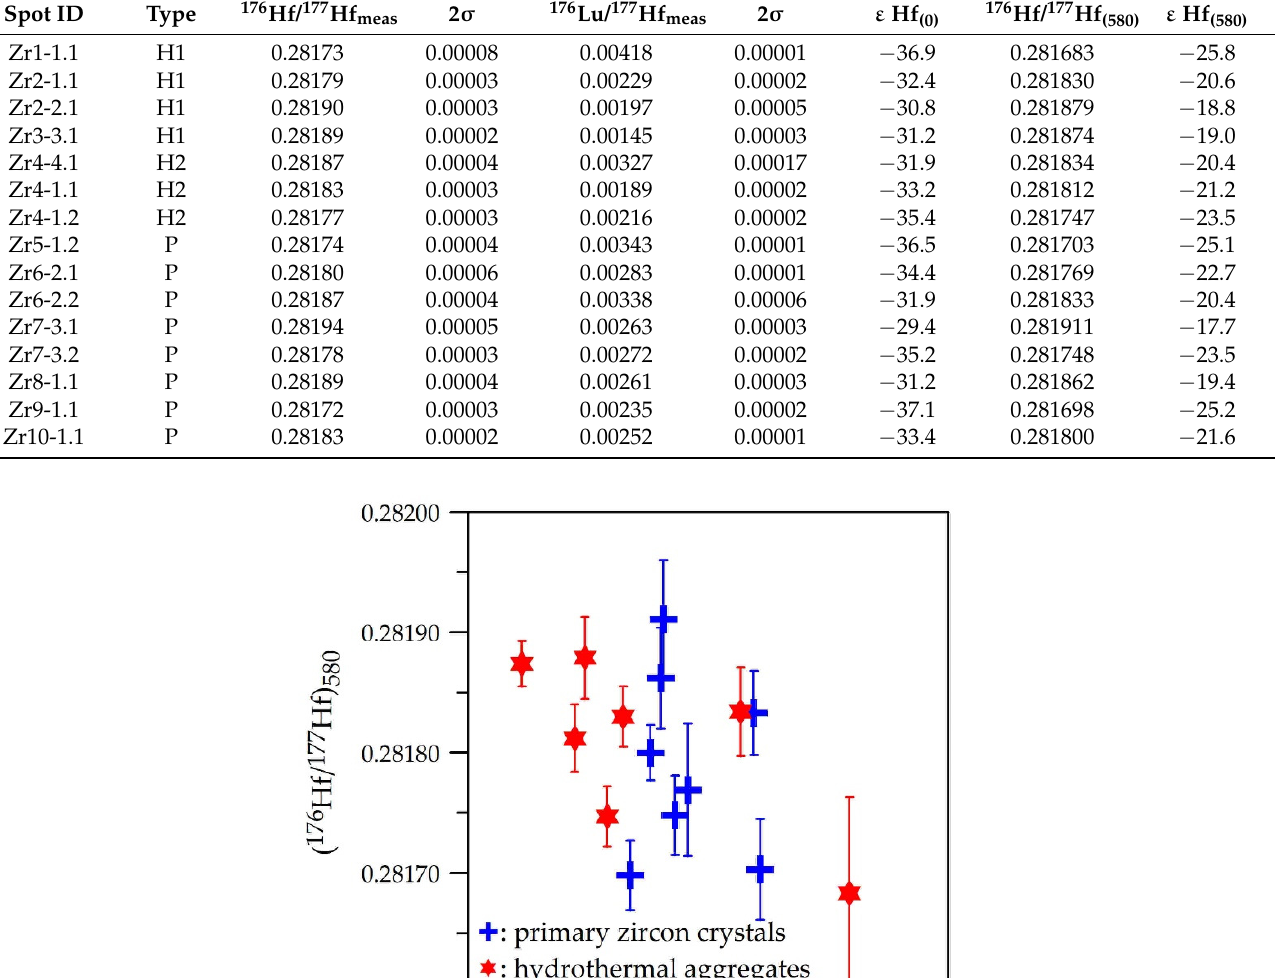
Table 3. In-zircon Lu and Hf measured (meas) and calculated isotope data for primary (P) and